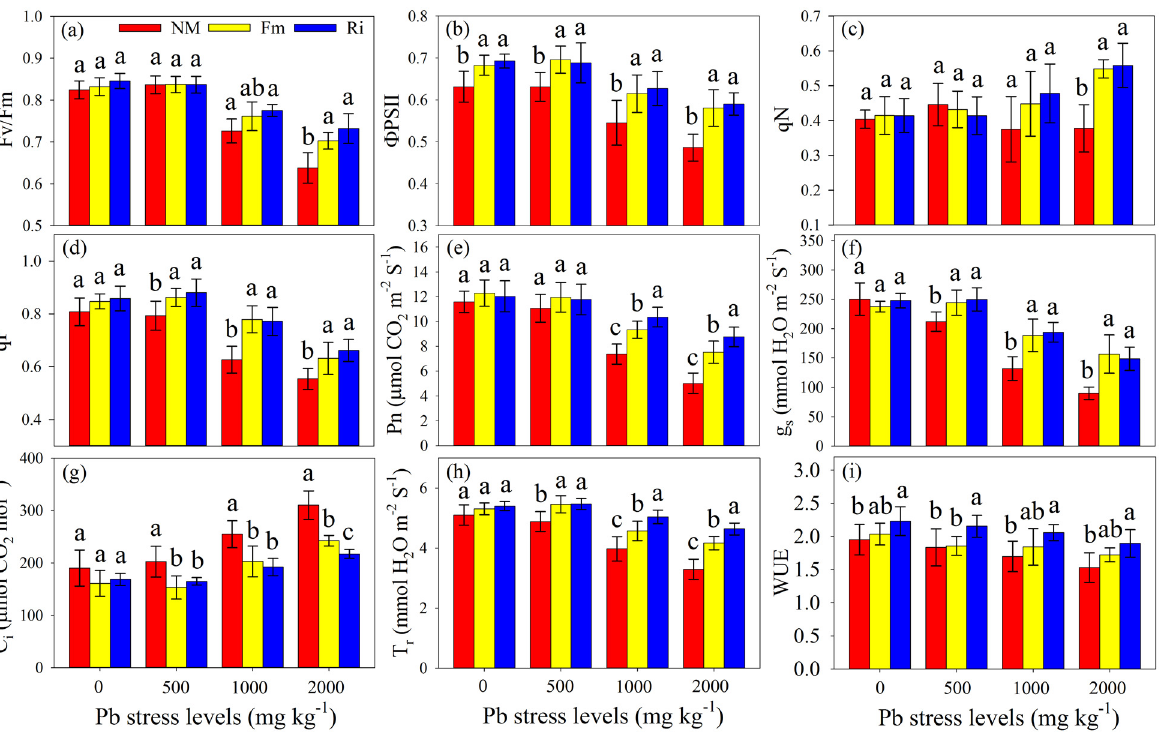
Fig 3. Fv/Fm (a), Φ PSII (b), qN (c), qP (d), Pn (e), g s (f), C i (g), T r (h) and WUE (i) in R . pseudoacacia leaves were affected by Pb stress levels and AMF inoculation. NM, non-inoculated control; Fm, inoculated with F . mosseae ; and Ri, inoculated with R . intraradices . The results are represented as the mean (n = 6) ± SD. The same letter indicates no significant difference among treatments (Duncan ’ s test, P < 0.05). Two-way ANOVAs were used to determine the significance of the effects of Pb stress (Pb), AMF inoculation (AMF), and their interactions (Pb × AMF) on those parameters, as shown in S2 and S3